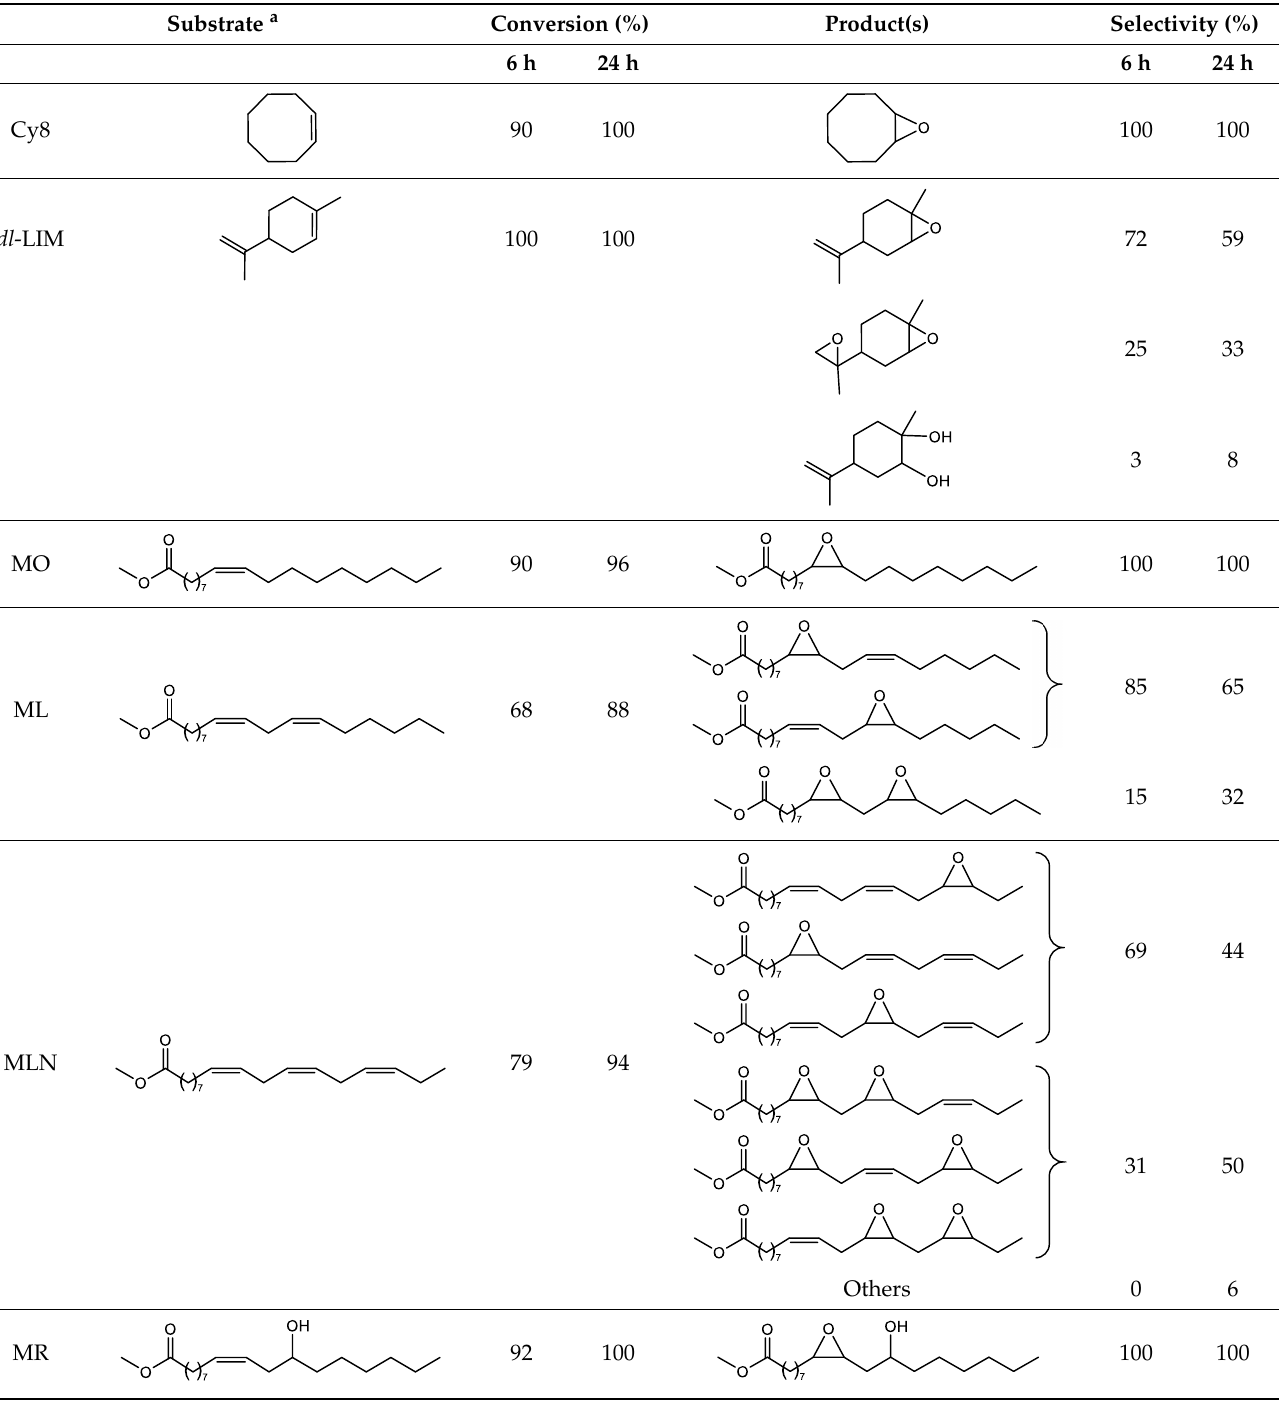
Figure 9. Kinetic profiles for the reaction of dl -limonene ( ● ), methyl oleate ( □ ), methyl linoleate ( ▲ ), methyl linolenate ( ◆ ), and methyl ricinoleate ( + ) with TBHP, in the presence of 2 , at 70 °C ( A ), and selectivity to the monoepoxides ( ● ) and diepoxides ( ○ ) of LIM ( B ), ML ( C ), and MLN ( D ) as a func- tion of olefin conversion. Dashed lines are visual guides. Table 1. Catalytic results for olefin epoxidation at 70 °C and sulfide oxidation at 35 °C, in the pres- ence of 2 using TBHP as oxidant.